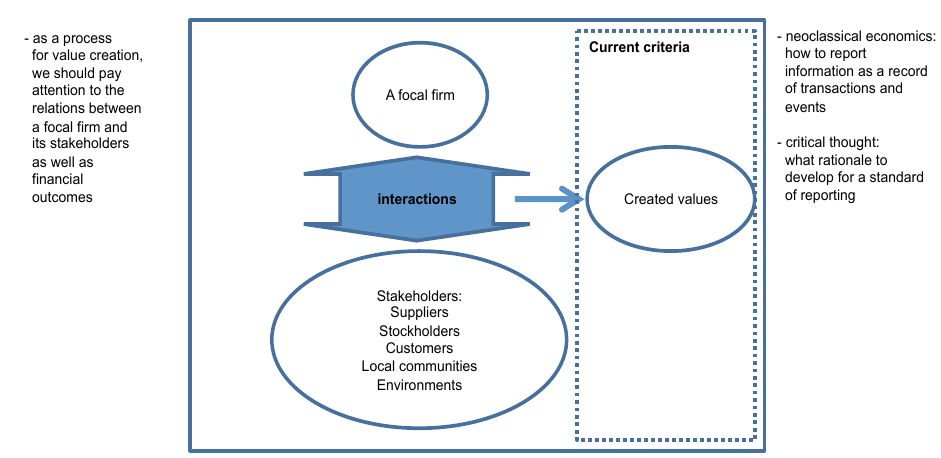
An expanded framework of